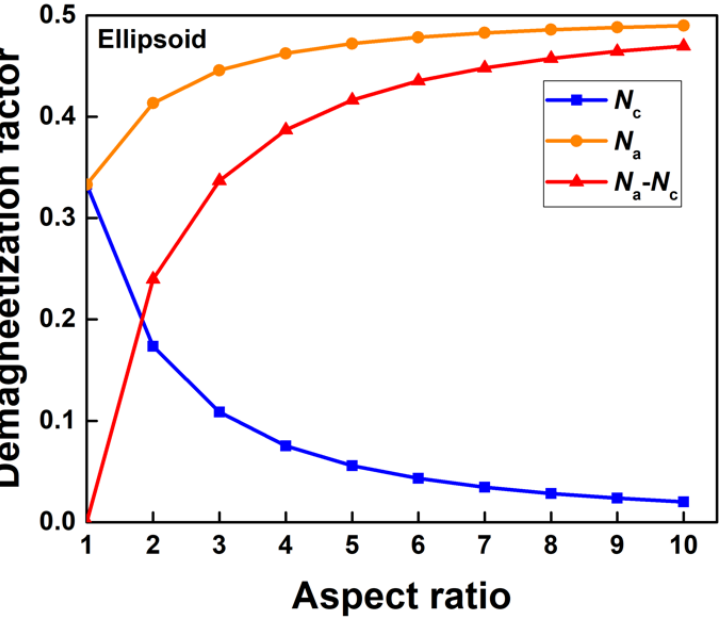
Figure 6. Calculated dependence of the demagnetization factors of an ellipsoid on its aspect ratio.